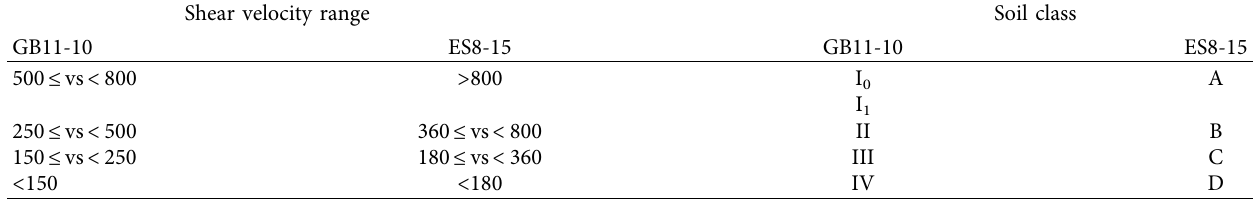
Table 8: Site classes equivalence of ES8-15 and